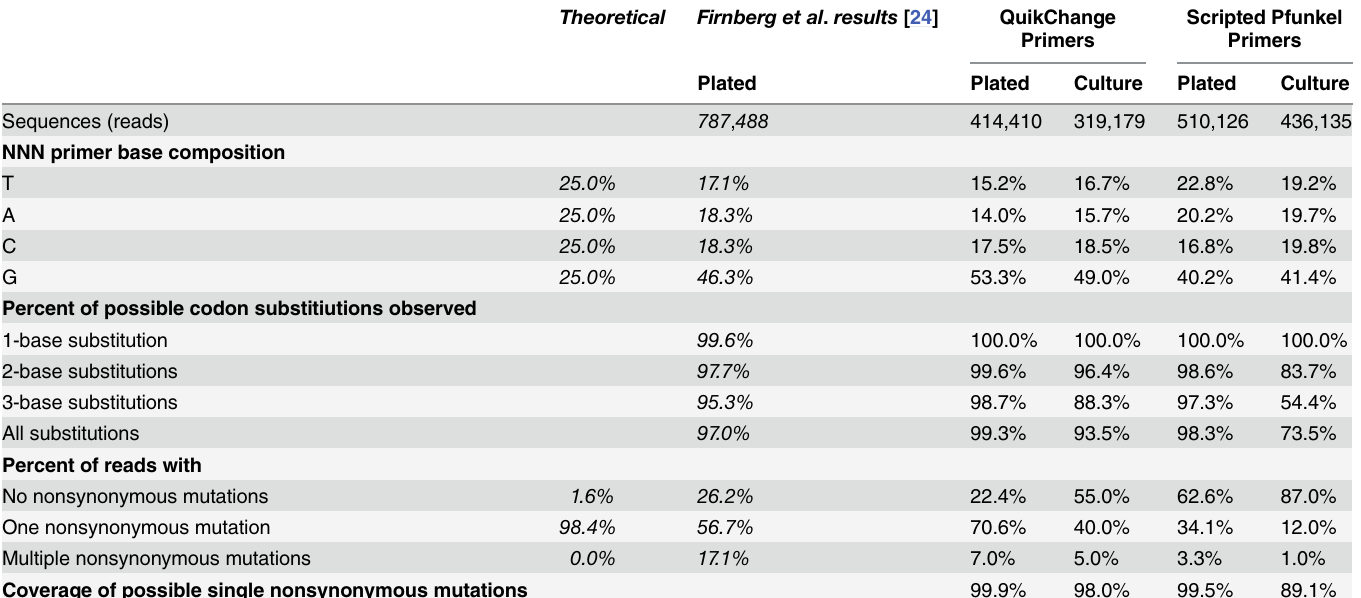
Table 1. Mutagenesis statistics for different experimental conditions. Comparisons to theoretical predictions and previous literature data are shown as reference